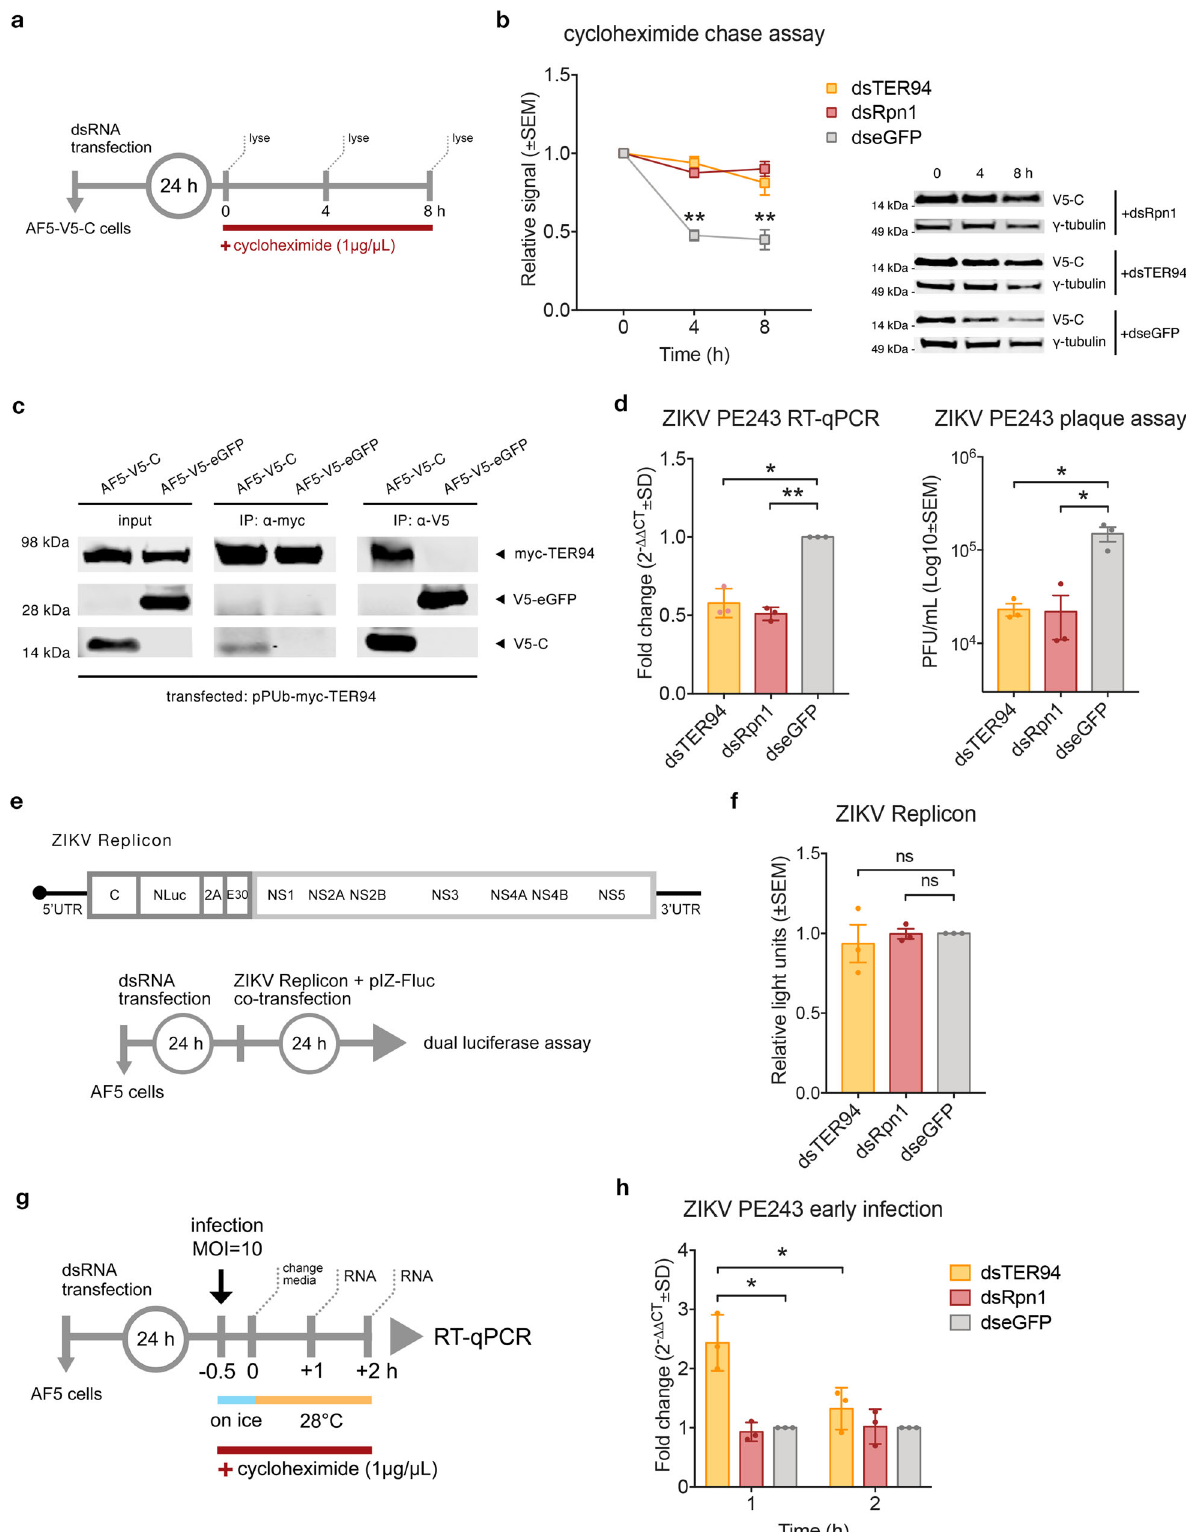
proteasomal degradation was avoided by treating with MG132 75,92 – 94 . Cell viability assays were performed prior to this experiment and only concentrations deemed to be non-cytotoxic for each inhibitor were used (Supplementary Fig. 2c). A549